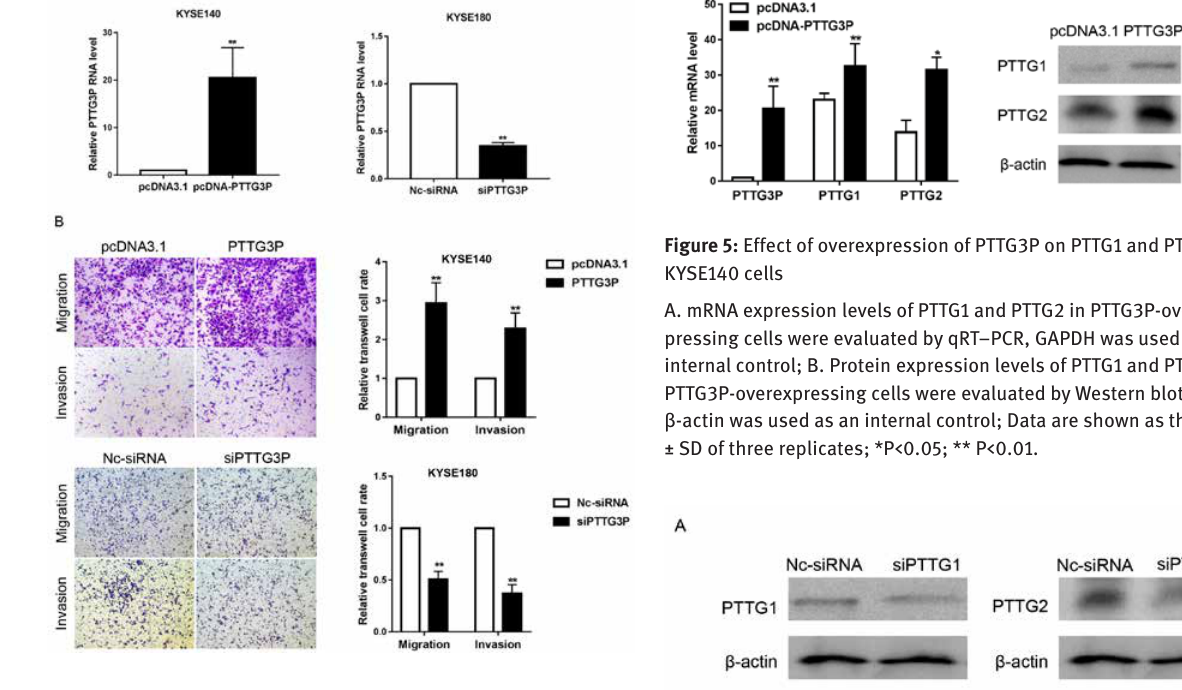
Figure 4: PTTG3P promoted cell invasion and migration in ESCC. A. mRNA expression levels of PTTG3P in PTTG3P-overexpressing KYSE140 cells and PTTG3P-knockdown KYSE180 cells were eva- luated by qRT–PCR, GAPDH was used as an internal control; B. for KYSE140 cells (Scale bars = 50μm); and quantification (the ratio